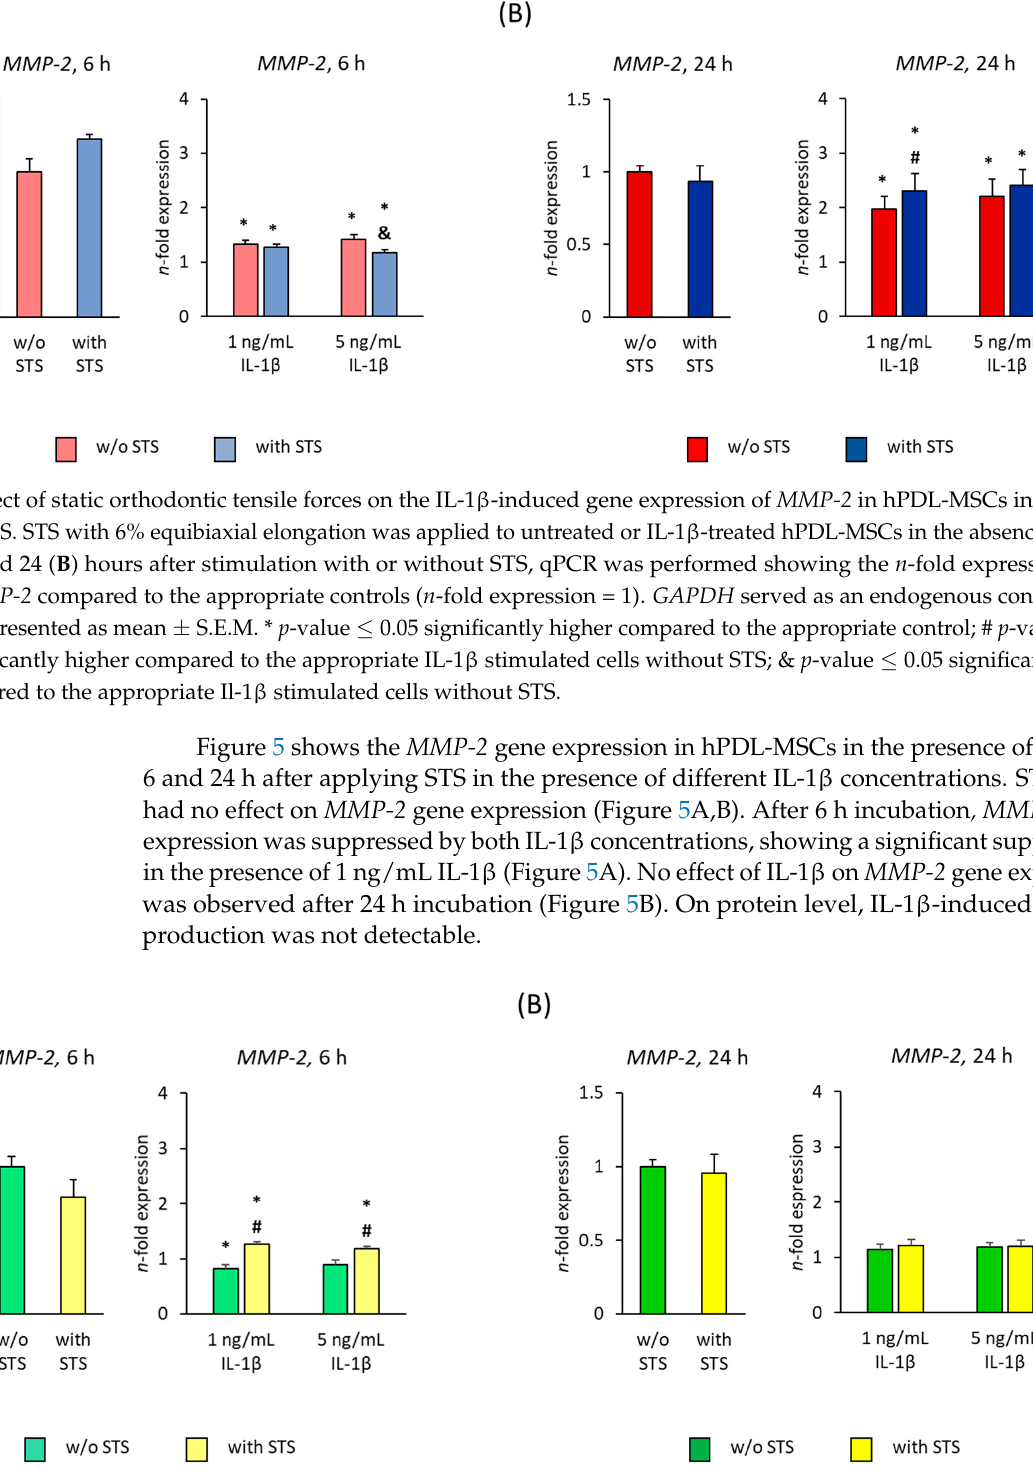
Figure 5. Effect of static orthodontic tensile forces on MMP-2 gene expression in hPDL-MSCs in the presence of IL-1 β and 2% FBS. STS with 6% equibiaxial elongation was applied to untreated or IL-1 β -treated hPDLSCs in the presence of 2% FBS. 6 ( A ) and 24 ( B ) hours after stimulation with or without STS, qPCR was performed showing the n -fold expression levels of MMP-2 compared to the appropriate controls ( n -fold expression = 1). GAPDH served as an endogenous control. All data are presented as mean ± S.E.M. * p -value ≤ 0.05 significantly higher compared to the appropriate control; # p -value ≤ 0.05 significantly higher compared to the appropriate IL-1 β stimulated cells without